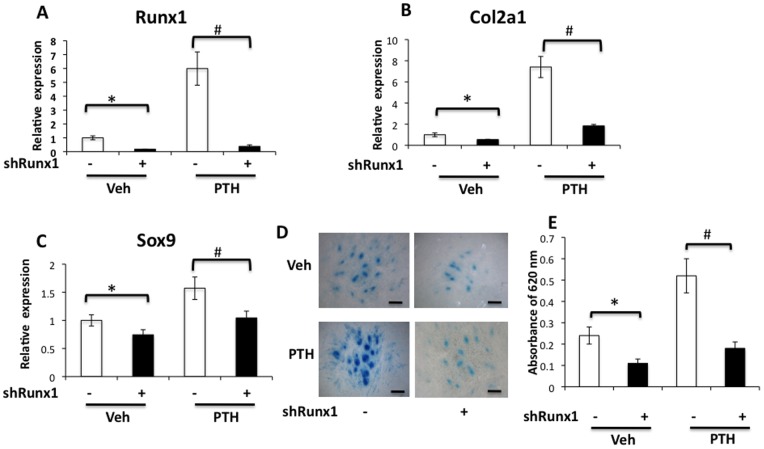
Knockdown of Runx1 impairs PTH-induced chondrogenesis.Limb bud cells were infected with Runx1 shRNA lentivirus and treated intermittently with PTH 1–34 for 4 days before being harvested at day 5 of culture for Alcian blue staining and RT-PCR analysis. (A) Runx1 knockdown significantly inhibited Runx1 gene expression and resulted in the inability of PTH to induce Runx1 expression. (B) Runx1 knockdown significantly inhibited type II collagen gene expression and significantly reduced PTH-induced type II collagen expression. (C) Sox9 gene expression was reduced by Runx1 knockdown in PTH- and vehicle-treated cells. (D) A drastic reduction in chondrocyte nodule formation was seen in PTH-treated cells that had Runx1 knocked down. Scale bars, 100 µm. (E) After solubilization in 6 M guanidine hydrochloride, blue staining taken up by the micromasses was quantified by measuring absorbance at 620 nm. Data (A, B, C, E) are means ± SD of three independent experiments performed in duplicate and the vehicle control gene expression level was set at 1. (*p<0.05 compared with vehicle control; #p<0.05 compared with PTH without shRunx1).